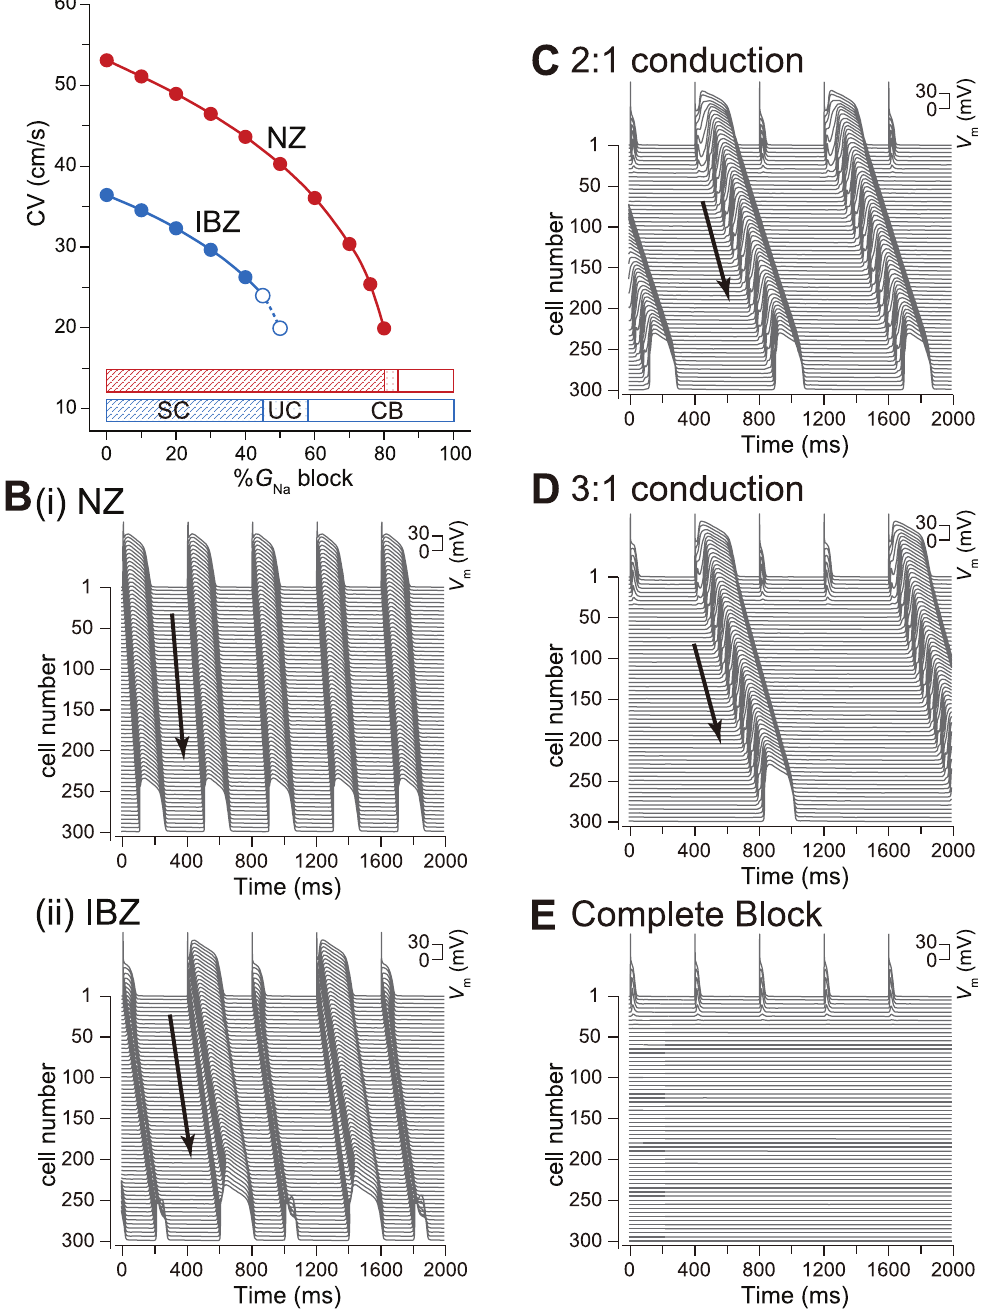
Figure 3. Destabilization of action potential propagation by Na + channel blockade. (A), Conduction velocity (CV) as a function of % G Na block. Open circles with the dashed lines denote CV under AP alternans. The relationship between the excitation conduction mode and % G Na block is represented by the bottom bars. SC, stable conduction; UC, unstable conduction (e.g., AP alternans, or 2:1 or 3:1 conduction); CB, complete conduction block. (B), Examples of AP propagation observed in NZ (i) and IBZ (ii) myofibers. (C)–(E), Examples of 2:1 conduction by 55% G Na block (C), 3:1 conduction by 56% G Na block (D), and complete conduction block by 60% G Na block (E) in the IBZ.